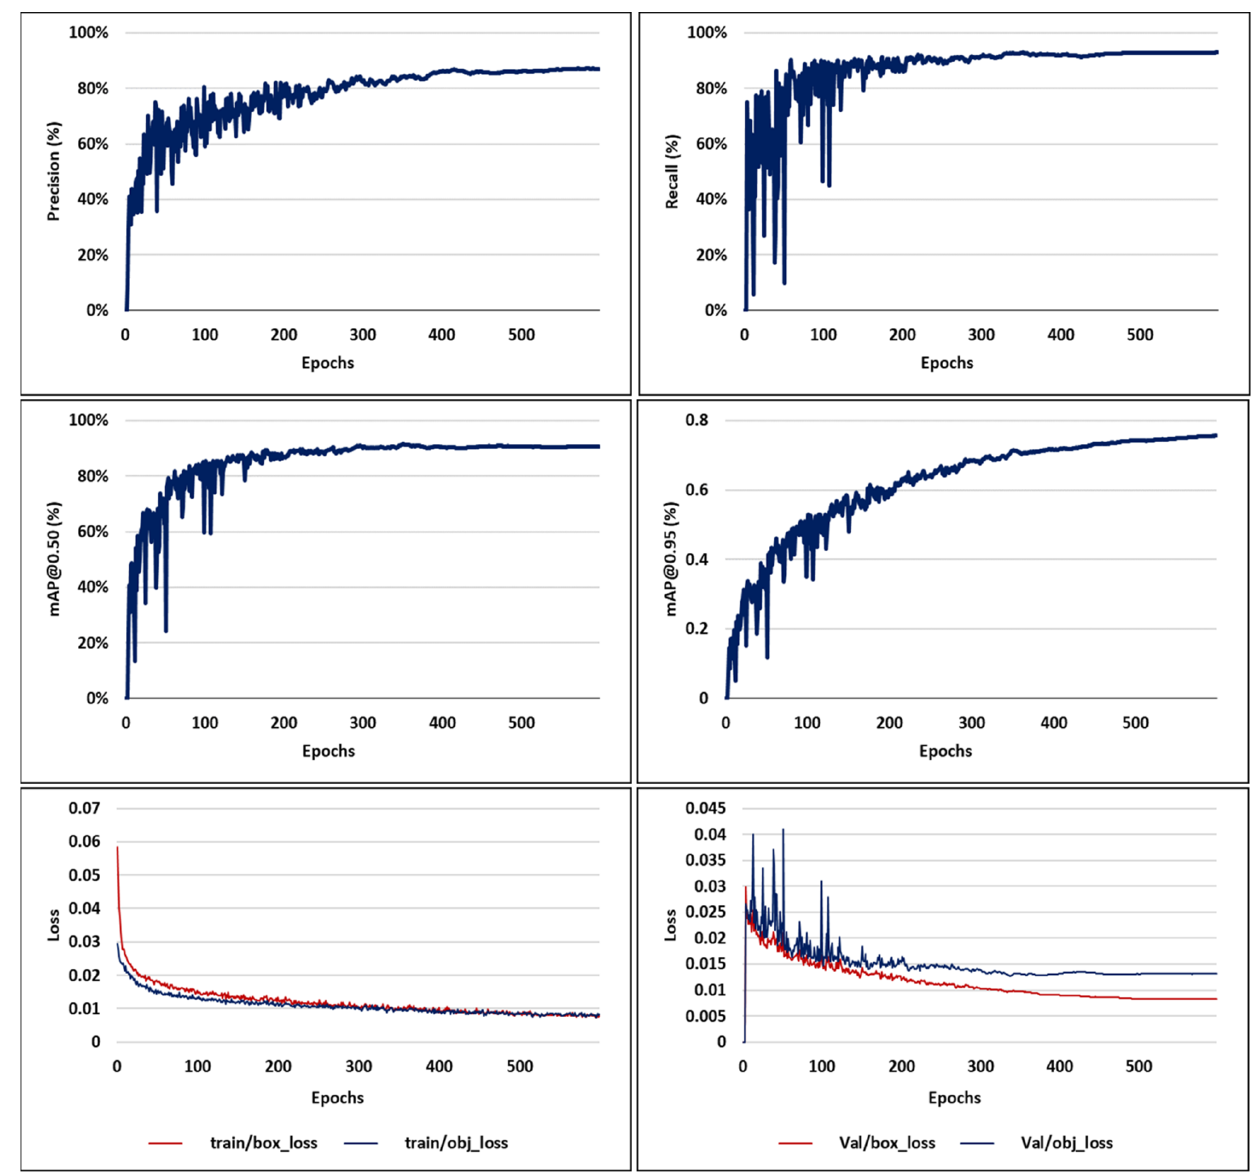
Figure 10. Visual analysis of YOLOR evaluation indicators during training.